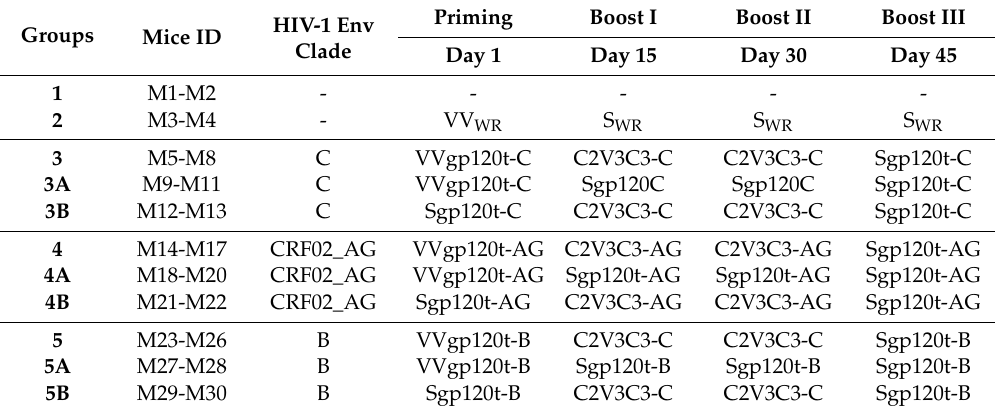
Table 2. BALB / c mice immunization scheme in the main